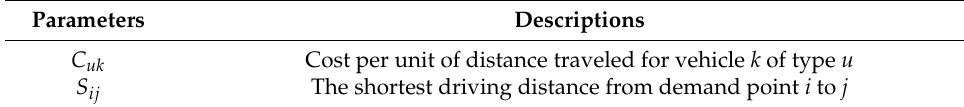
Table 2. Parameters’ symbols and descriptions.